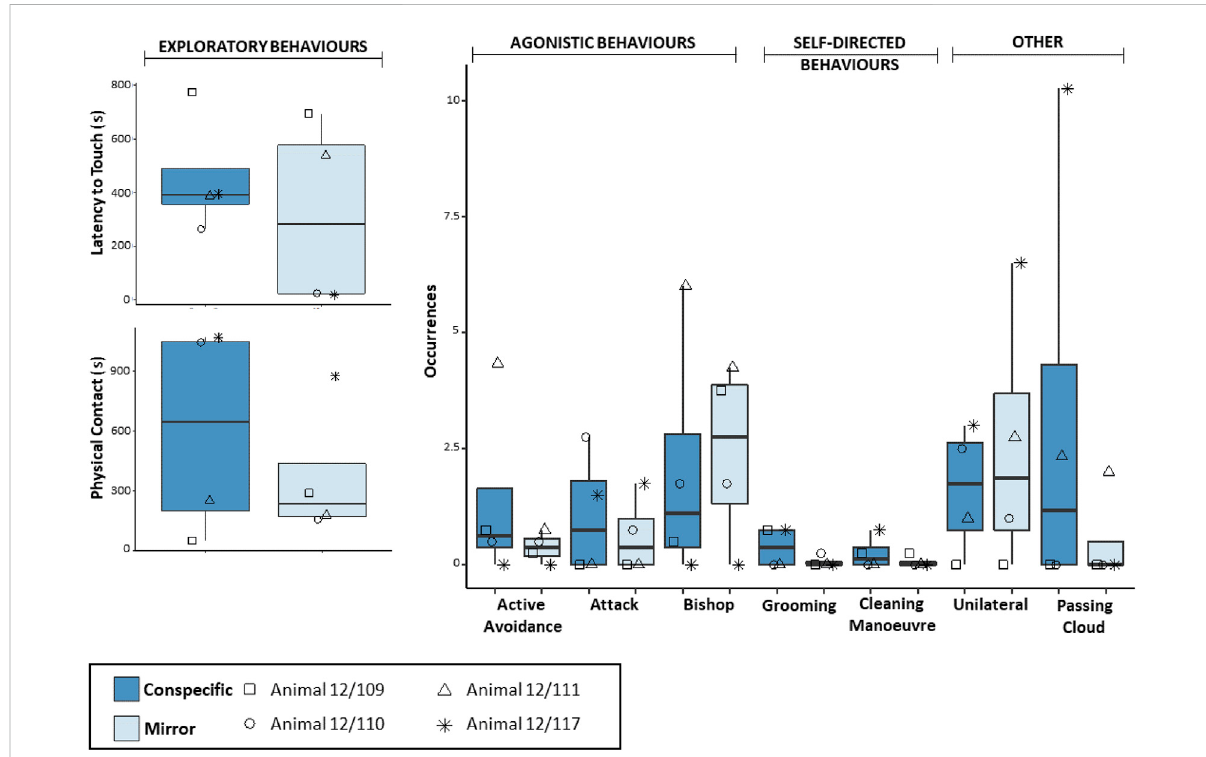
FIGURE 3 Box and whisker plot of the responses of O. vulgaris ( Social group) to the mirror (light blue) and the conspeci fi c (dark-blue) during the familiarization phase.